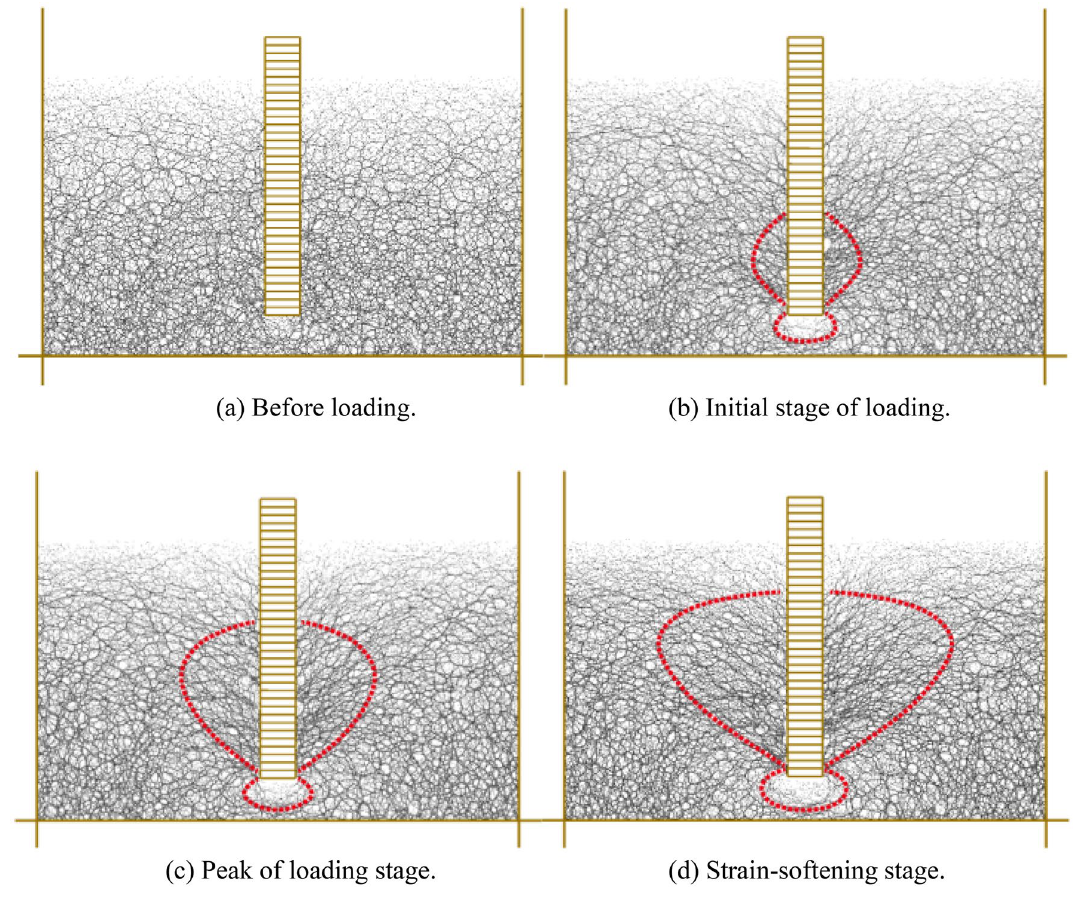
Figure 14. Force chain distribution at different stages of